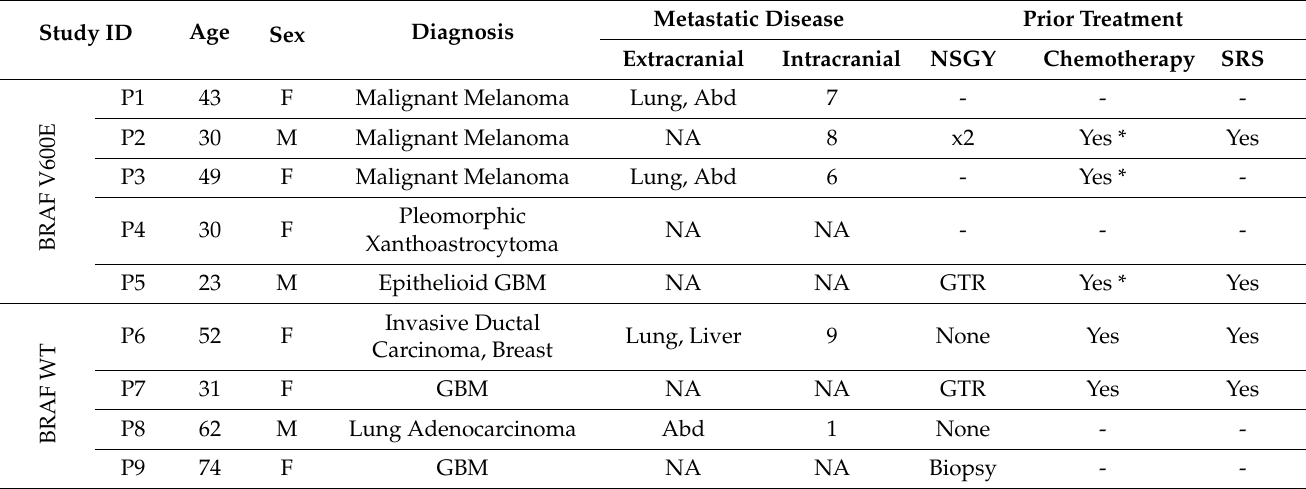
Table 1. Baseline characteristics of individual patients.